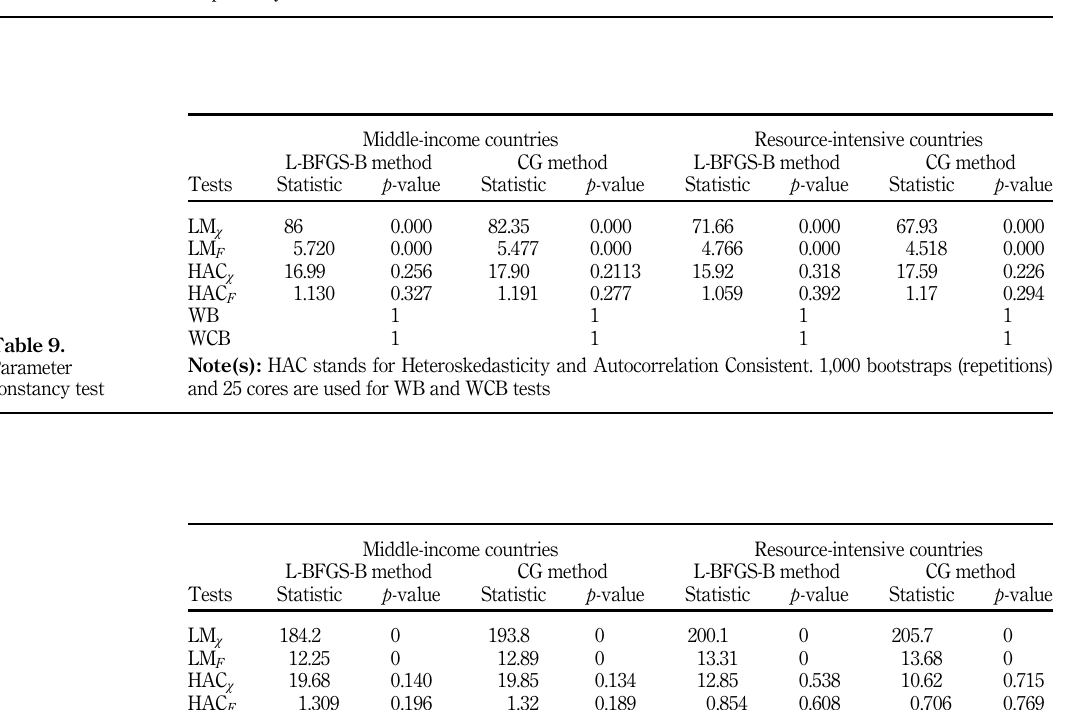
estimation for resource-intensive countries